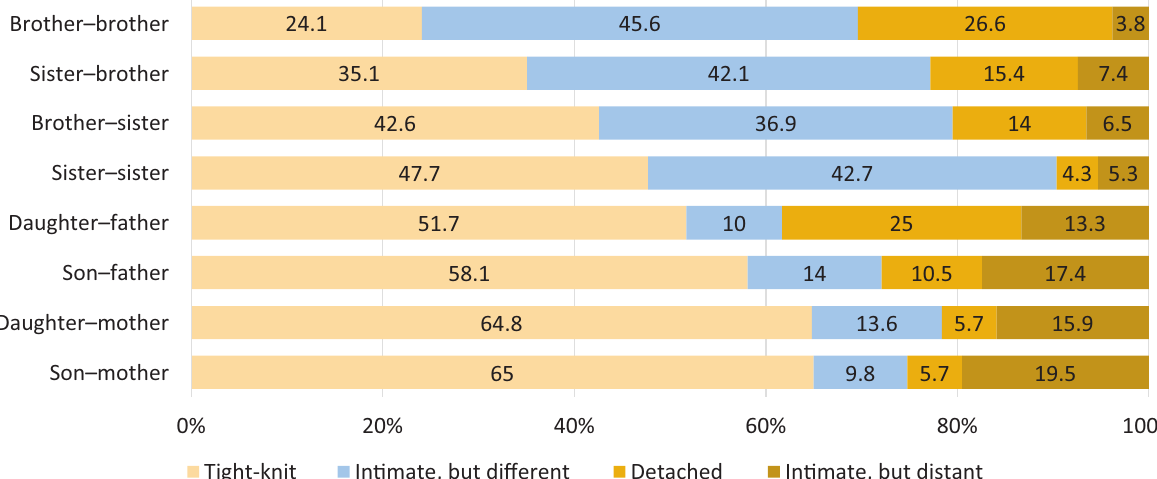
Figure 4. Solidarity within and between generations in Lithuanian migrant families. Notes: The typology of relationships developed based on the information about 227 sibling dyads and 357 adult child–parent dyads (584 dyads in total); the respondent is presented as the first part of the dyad (for example, the sister–brother dyad indicates that it refers to the relationship between the female respondent and her brother). Source: Data derived from the 2018 quota survey Migration and Family Processes: Quota Study of the Lithuanian population with direct migration